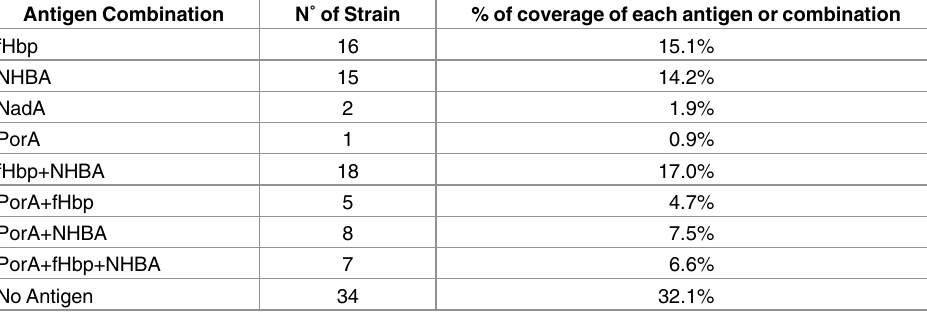
Table 2. Percentage of Portuguese strains covered by each one of 4CMenB and